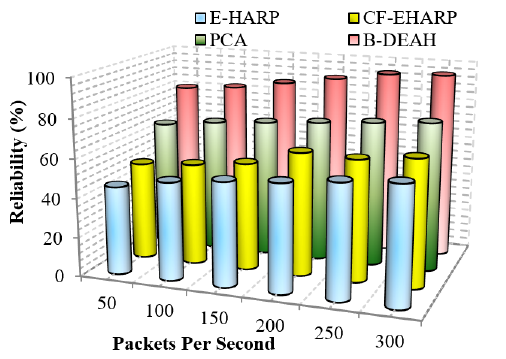
Figure 20. Reliability vs. packets per